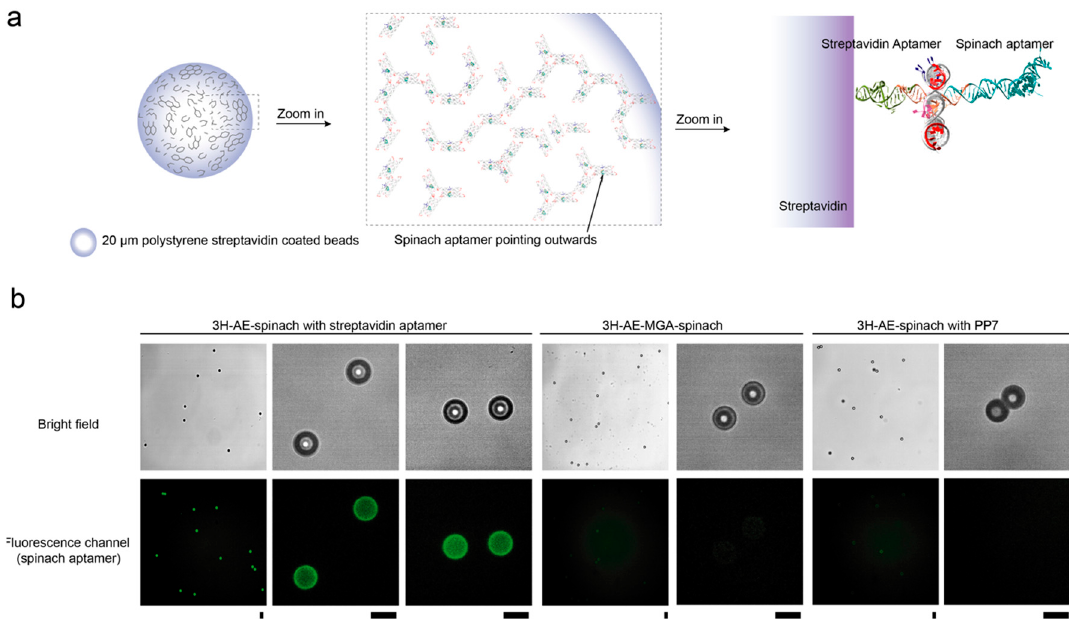
Figure 6. Assembly of double-functionalized 3H-AE tiles on microparticles. ( a ) schematic representation of attachment of 3H-AE-Spinach tiles with streptavidin aptamer on the surface of streptavidin coated beads. The streptavidin aptamer is expected to be anchored on the surface of streptavidin particles and thus the Spinach aptamer points away from it; ( b ) fluorescence images of different RNA tiles interacting with 20 µm streptavidin coated polystyrene beads after washing. Only the RNA tiles carrying Spinach and a streptavidin aptamer lead to a fluorescent signal localized to the beads; scale bars: 20 µm.